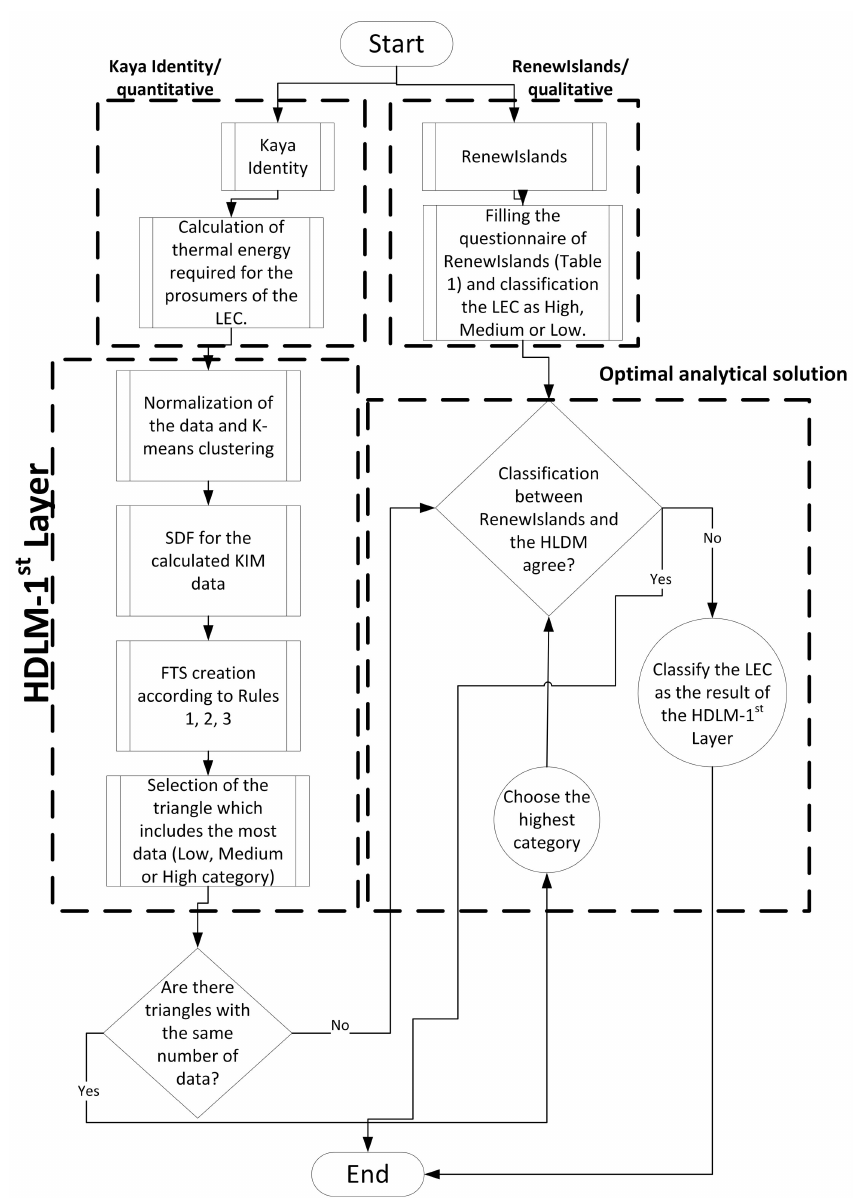
Figure 1. Logic diagram representing the proposed methodology